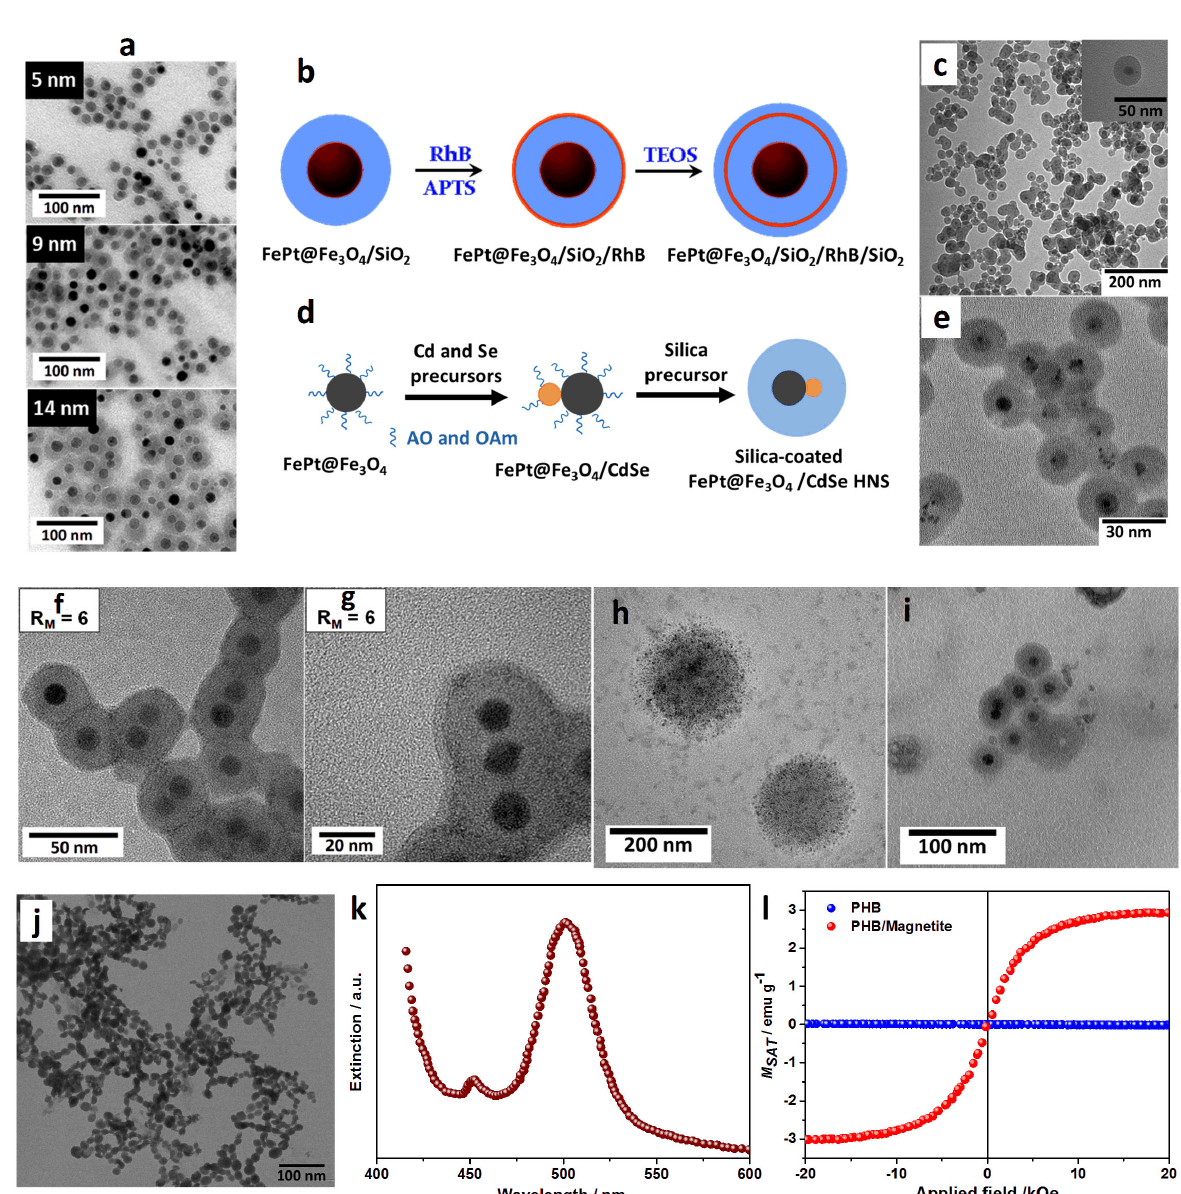
Figure 6 - ( a ) Typical TEM images of silica-coated magnetite nanoparticles with 5 nm, 9 nm and 14 nm of SiO 2 shell thickness, ( b ) Schematic representation of the layer-by-layer synthesis and (c) TEM images of obtained FePt@Fe 3 O 4 /SiO 2 /RhB/SiO 2 luminomagnetic material. Inset in ( c ) showed an individual LMNP. ( d ) Schematic synthesis strategy and ( e ) TEM image of the silica-coated FePt/Fe 3 O 4 -CdSe luminomagnetic heteronanostructure. ( f ) and ( g ) TEM images of titania-coated Fe 3 O 4 @SiO 2 magnetic nanocatalysts with TiO 2 shell thickness of 2 nm. Chitosan nanoencapsulation of magnetite nanoparticles by ionic gelification using ( h ) DMSA-coated magnetite and ( i ) hot-methanol washed nanoparticles shown individual coated-nanoparticles. ( j ) PHB nanoparticles scanning electron microscopy image. ( k ) UV-Vis spectra and ( l ) magnetic hysteresis loops of PHB-encapsulated CdSe and magnetite nanoparticles,